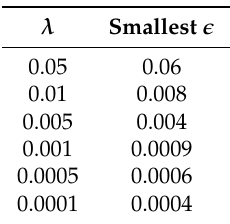
Table 2. Selection of the Constant λ for the Hybrid BRGD-SBRD